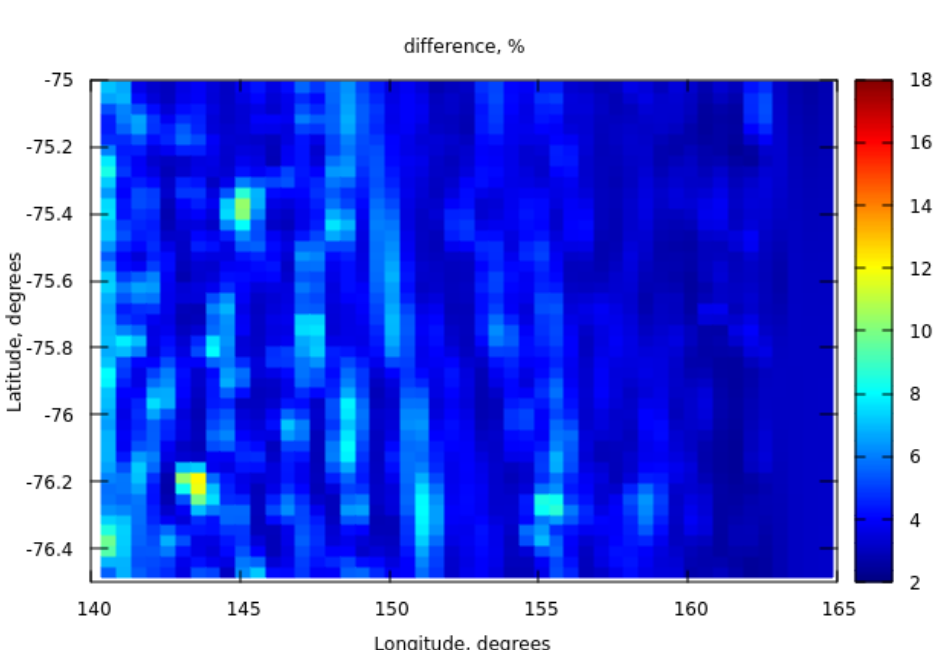
Figure 8. The difference (in percent, see Equation (75)) between measured and modelled spectra.